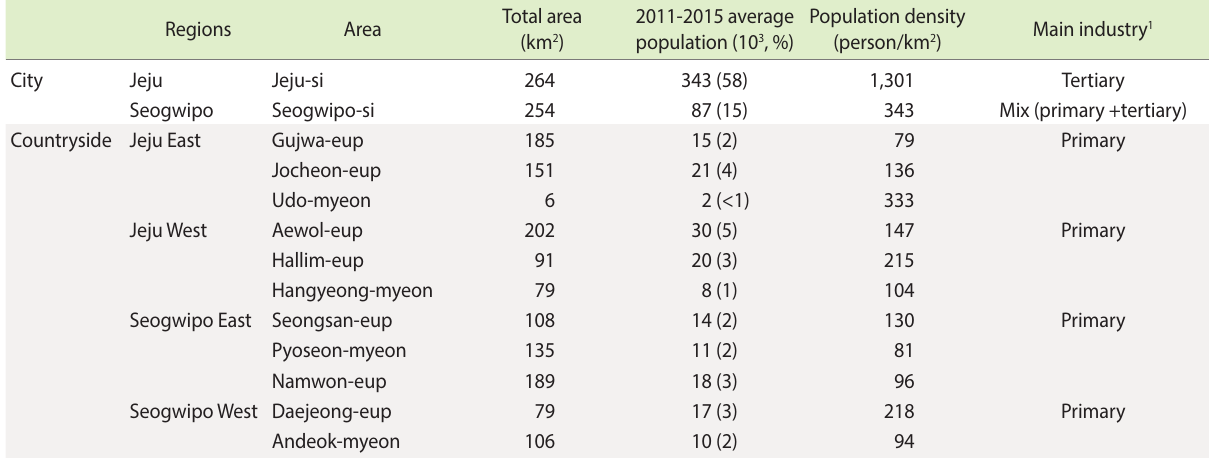
Table 1. Brief regional demographics of Jeju Island